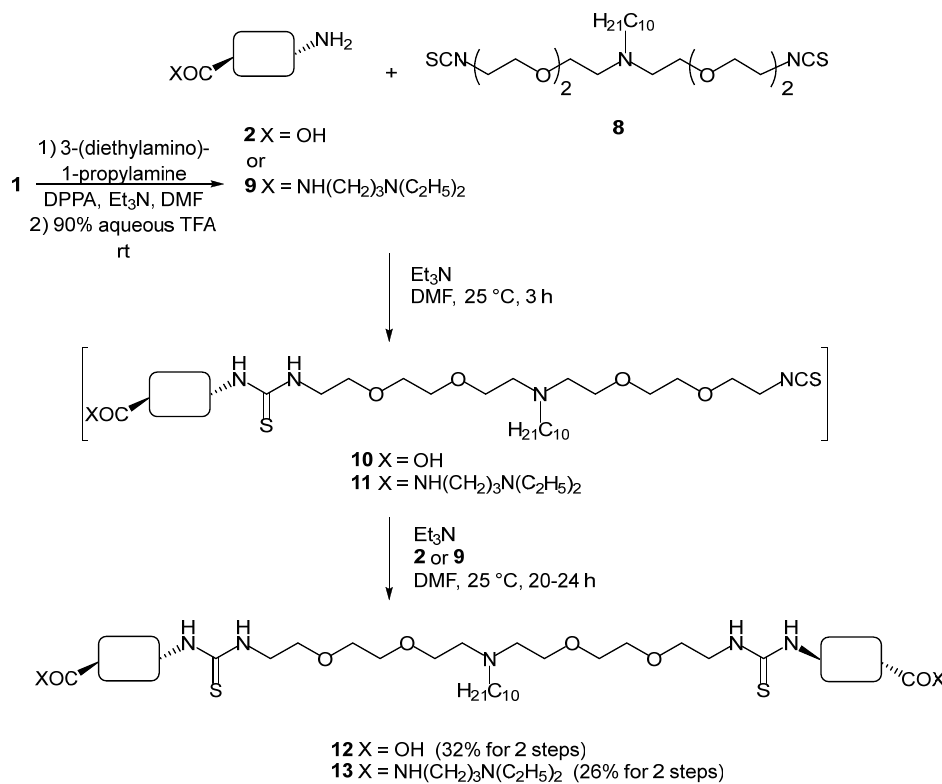
Scheme 3. Synthesis of covalent dimers of teicoplanin pseudoaglycone 2 with N - N